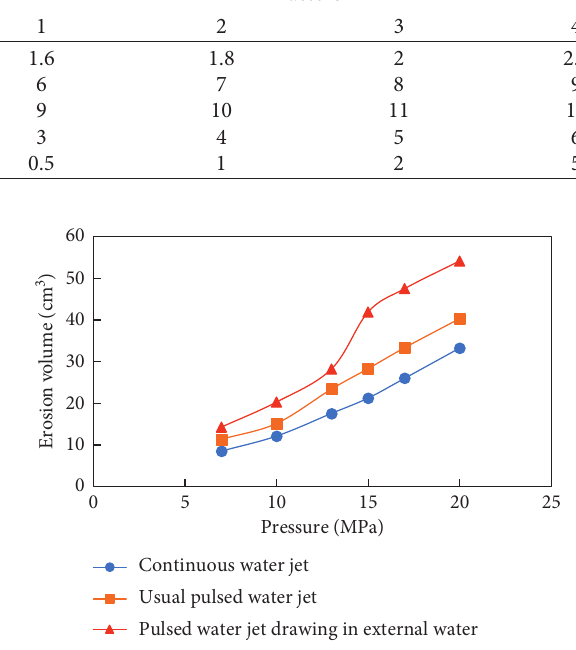
Figure 5: Effect of pump pressure on the erosion performance (when the jet standoff distance is 15 Table 3: Effect of the drawing type on the erosion performance.